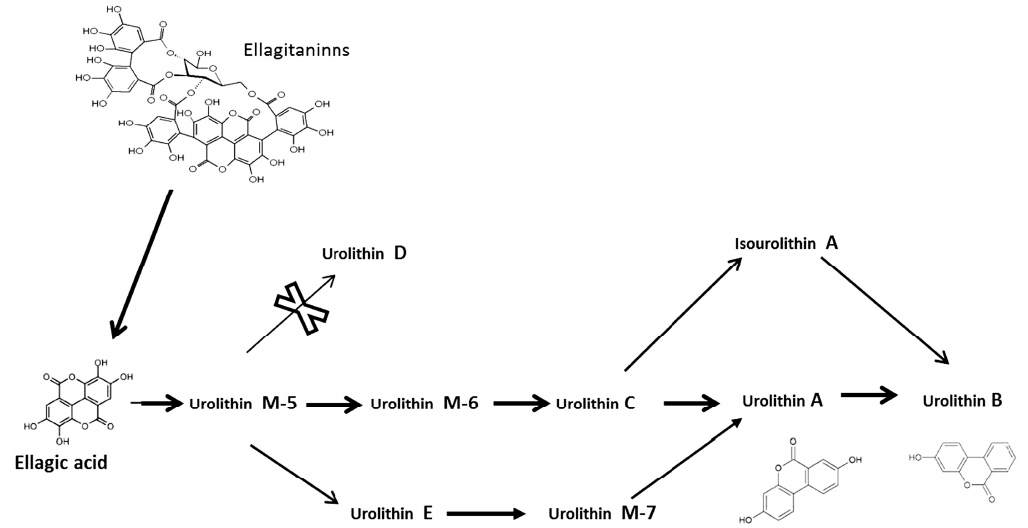
Figure 2. Metabolism of ellagitannins and ellagic acid by intestinal microbiota.